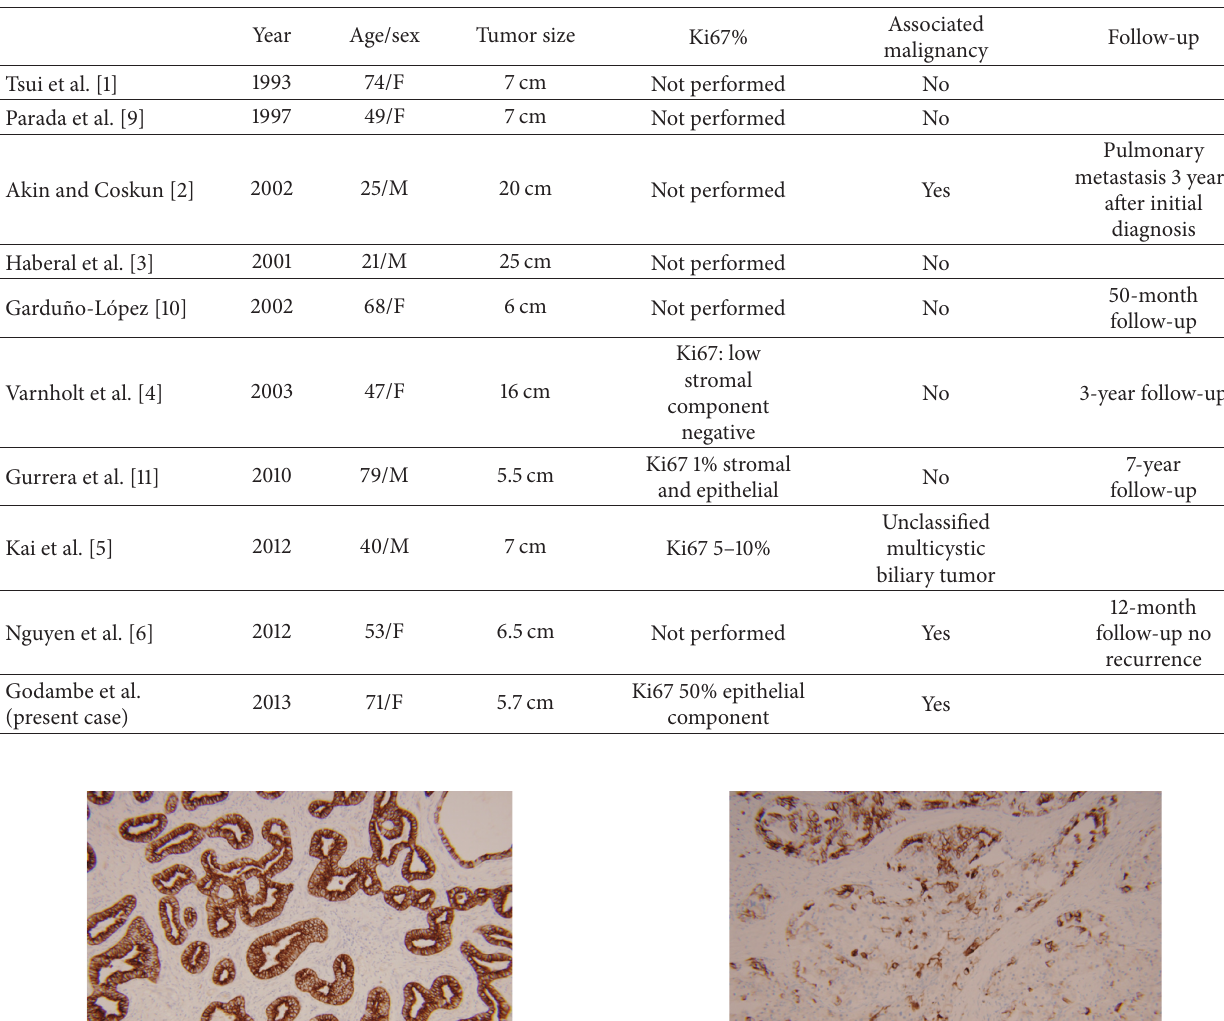
Table 1: Clinical and pathologic features of biliary adenofibromata reported in the literature.